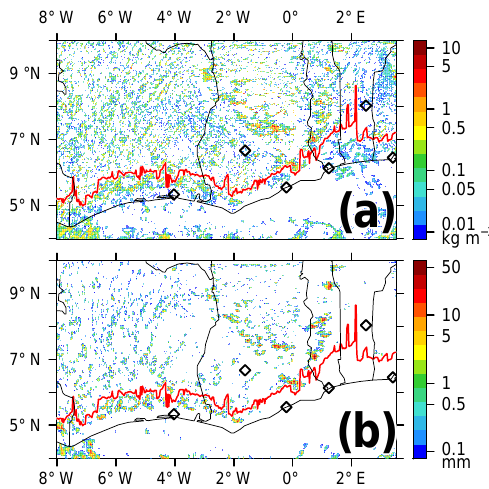
Figure 12. (a) Total cloud water (kgm − 2 ) and (b) precipitation (mm) on 2 July 15:00UTC for the reference case. The red line de- notes the AI